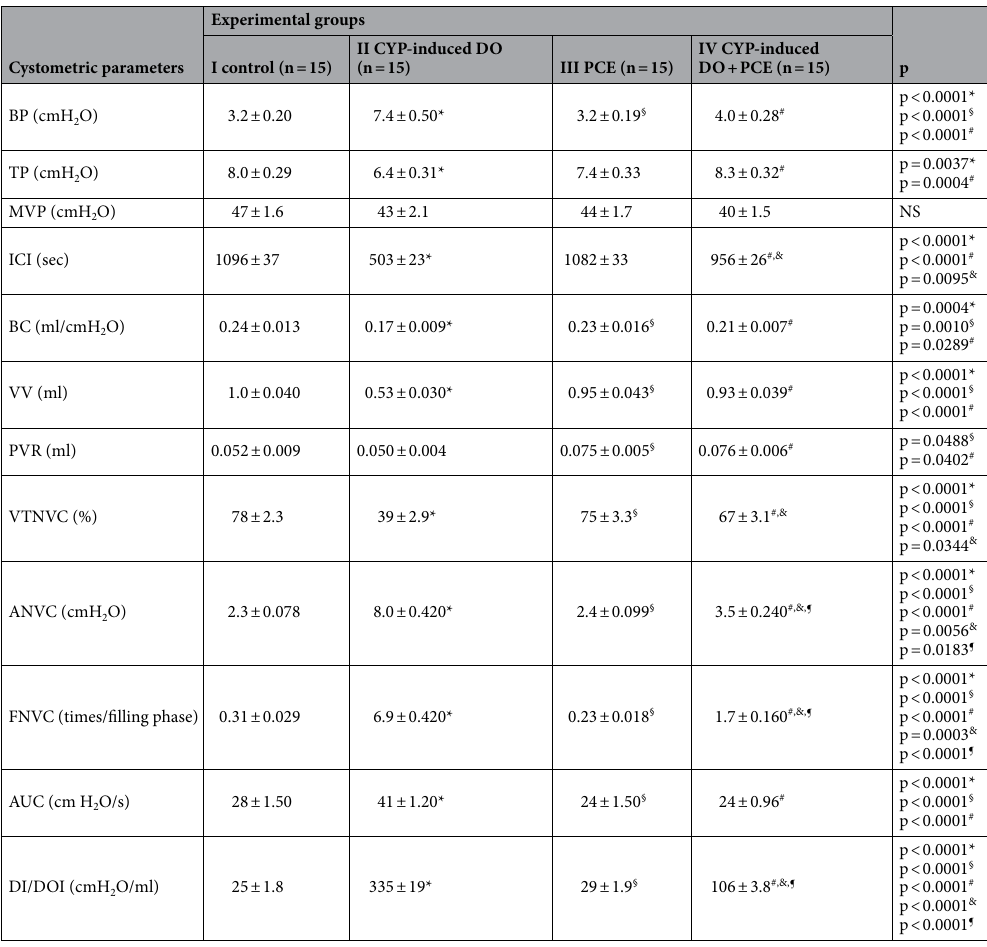
Table 2. Cystometric parameters of experimental groups. *Statistically significant differences between group I and group II (p ≤ 0.05), § Statistically significant differences between group II and group III (p ≤ 0.05), # Statistically significant differences between group II and group IV (p ≤ 0.05), & Statistically significant differences between group I and group IV (p ≤ 0.05), ¶ Statistically significant differences between group III and group IV (p ≤